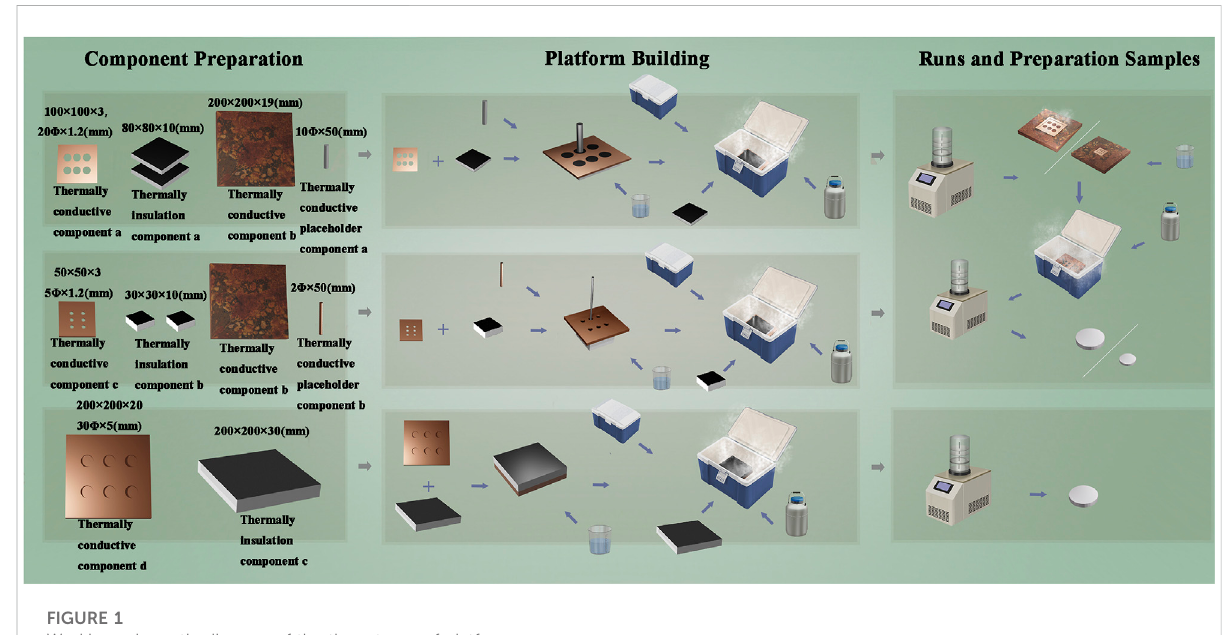
FIGURE 1 Working schematic diagram of the three types of